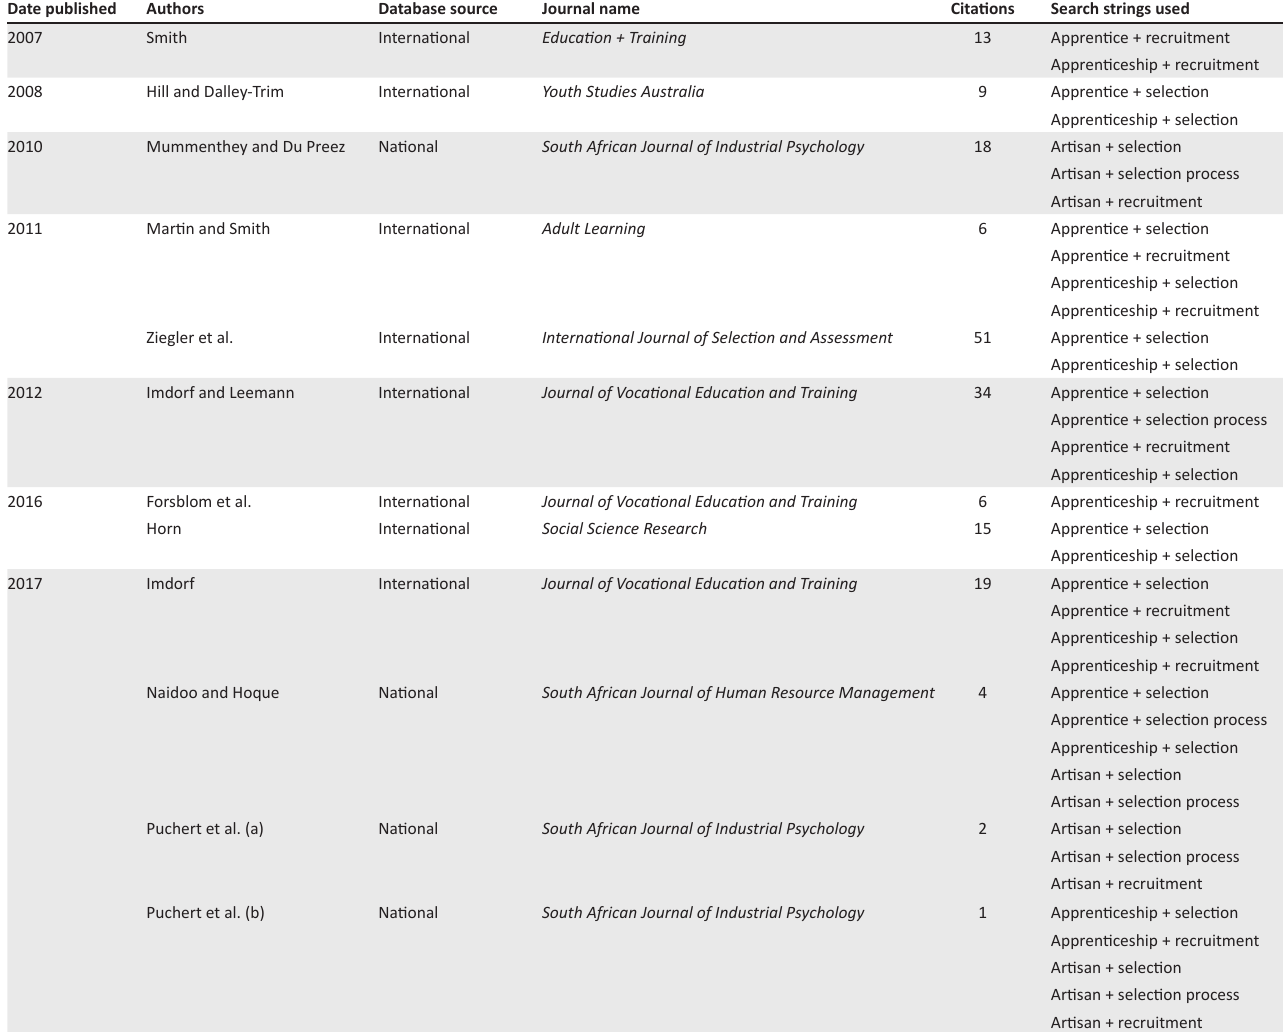
TABLE 4: Summary of final systematic literature review